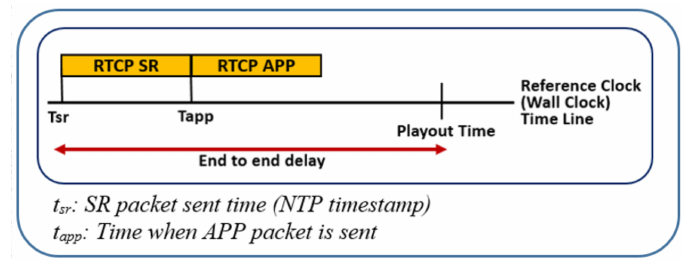
Figure 7. A timeline overview of the